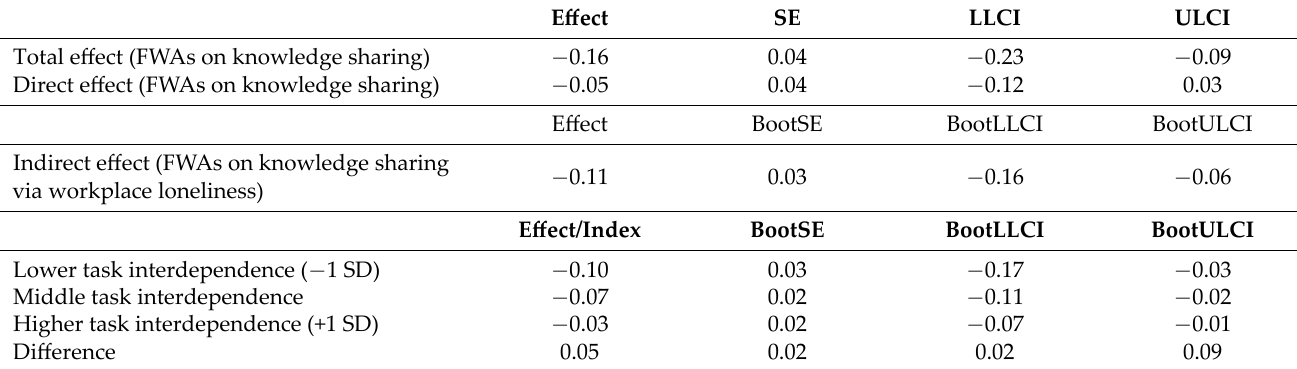
Table 6. Mediation effect and moderated mediation analyses of Study 2.